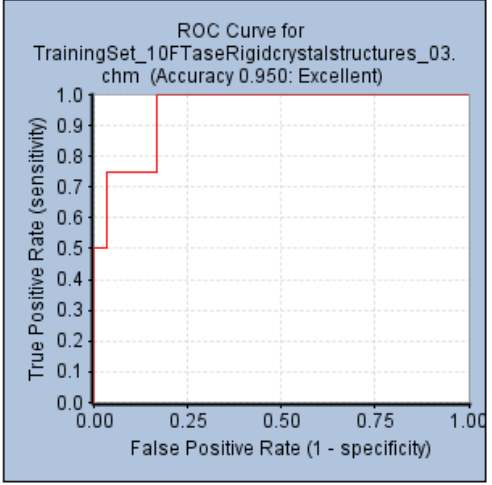
Figure 7. ROC curve of hypothesis